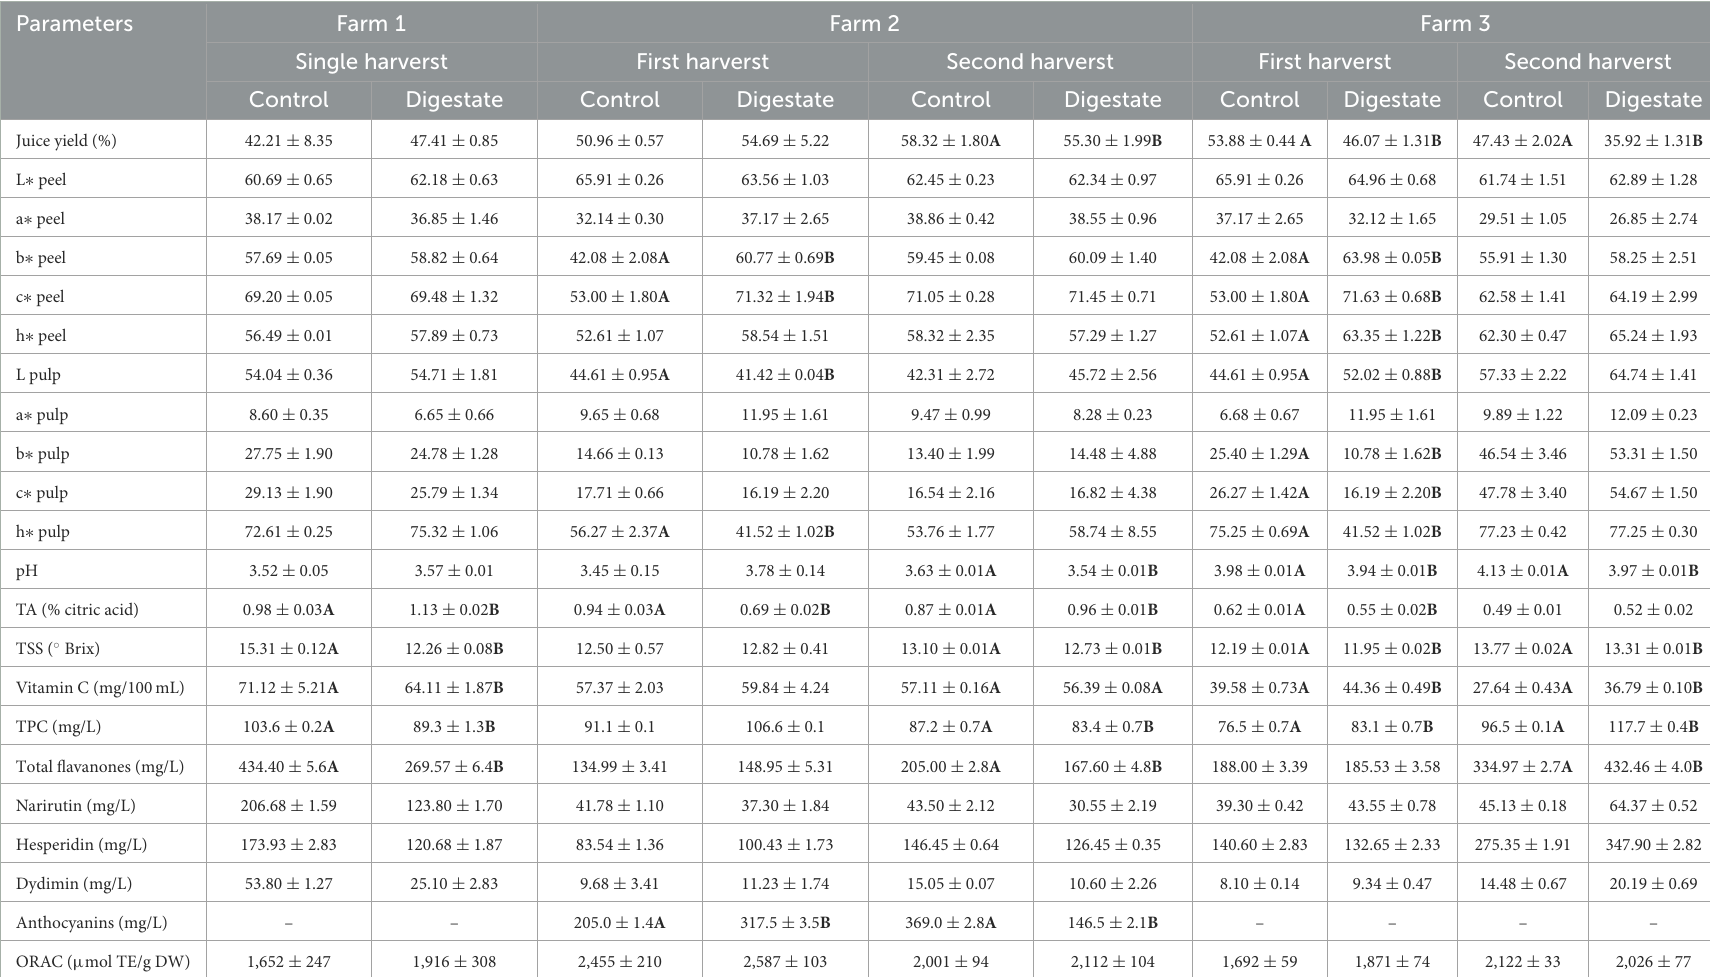
TABLE 3 Physicochemical parameters, bioactive compounds concentration and antioxidant activity evaluated in Citrus sinensis